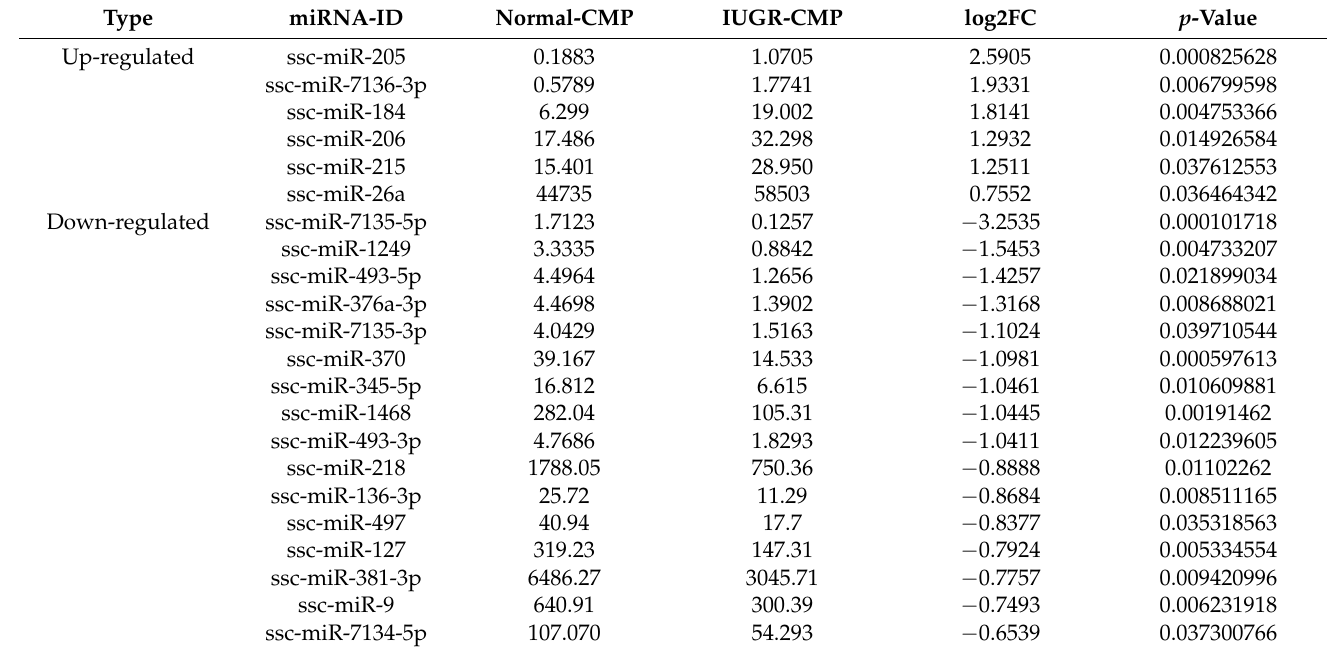
Table 1. List of miRNA populations differentially expressed in the spleen between Normal and IUGR pigs.